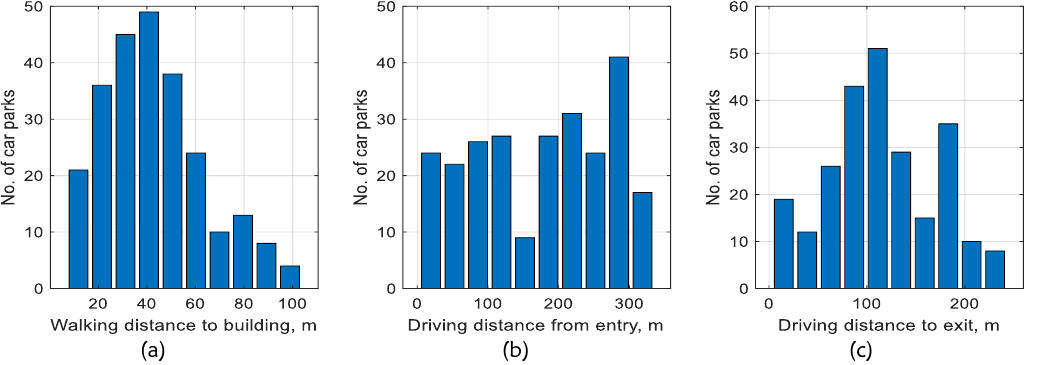
Figure 3: Histograms of car parks vs (a) walking distance from a parking point to the building entrance, (b) driving distance from the parking lot entrance to a parking point, and (c) driving distance from the parking point to the parking lot exit.